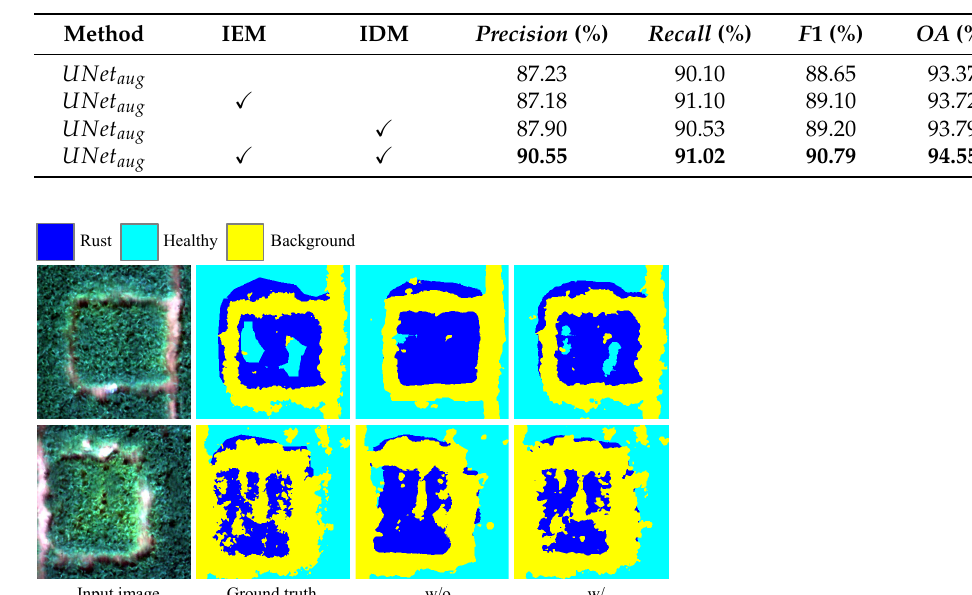
Table 4. The ablation studies about IEM and IDM.